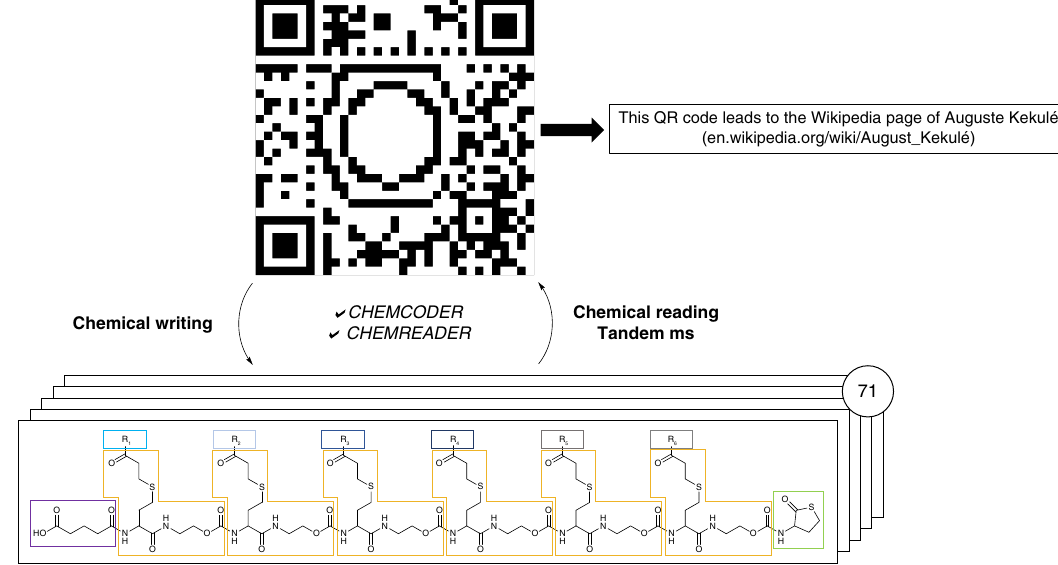
Fig. 1 Schematic representation of the QR code conversion. A QR code including a benzene structure, encoding the URL of the Wikipedia page of August Kekulé, who was the fi rst to understand the structure of benzene and made a proposal for its structure, is translated to and written on 71 different sequences. Translation is done using the Chemcoder algorithm. The sequences are read afterwards by means of tandem MS and the Chemreader algorithm. Given these sequences, Chemcoder is able to reconstruct the original QR code. Different building blocks in the sequence are highlighted: start fragment (purple box); backbone (yellow boxes), stop fragment (green box) and the functionalities (grey and blue